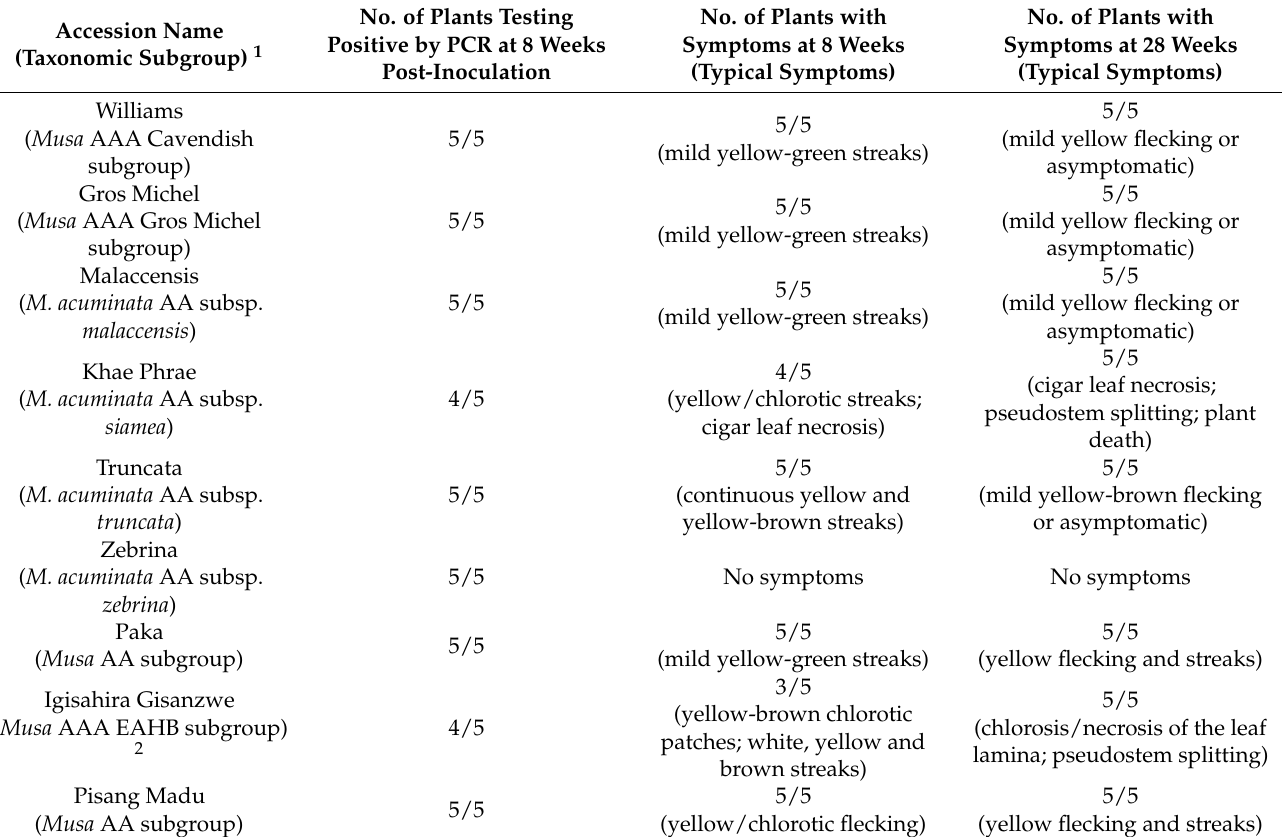
Table 1. Host range and symptoms of the BSCAV infectious clone in Musa acuminata